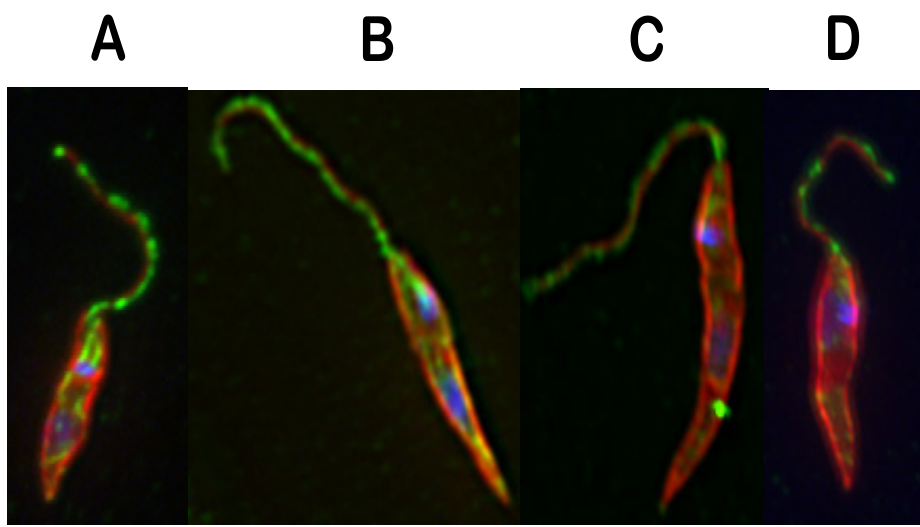
Figure 2. Immunofluorescence of L. donovani promastigotes transfected with either wild type or altered LmAQP1 and/or LmMPK2. A) overexpression of LmAQP1, B) co-expression of LmAQP1 and MPK2, C) overexpression of T197A LmAQP1, D) co-expression of LmAQP1 and MPK2 K42A. Cells were stained for LmAQP1 (green), α -tubulin (red); and DNA (blue). The three fluorescence images were finally